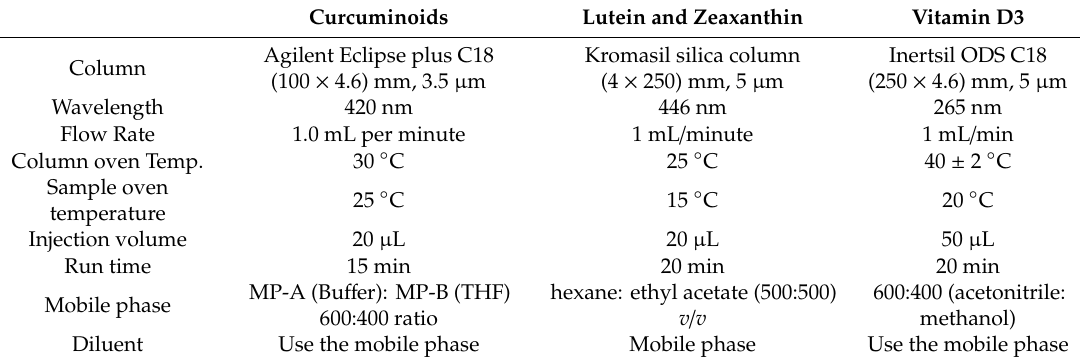
Table 3. HPLC run condition for the samples. Curcuminoids Lutein and Zeaxanthin Vitamin